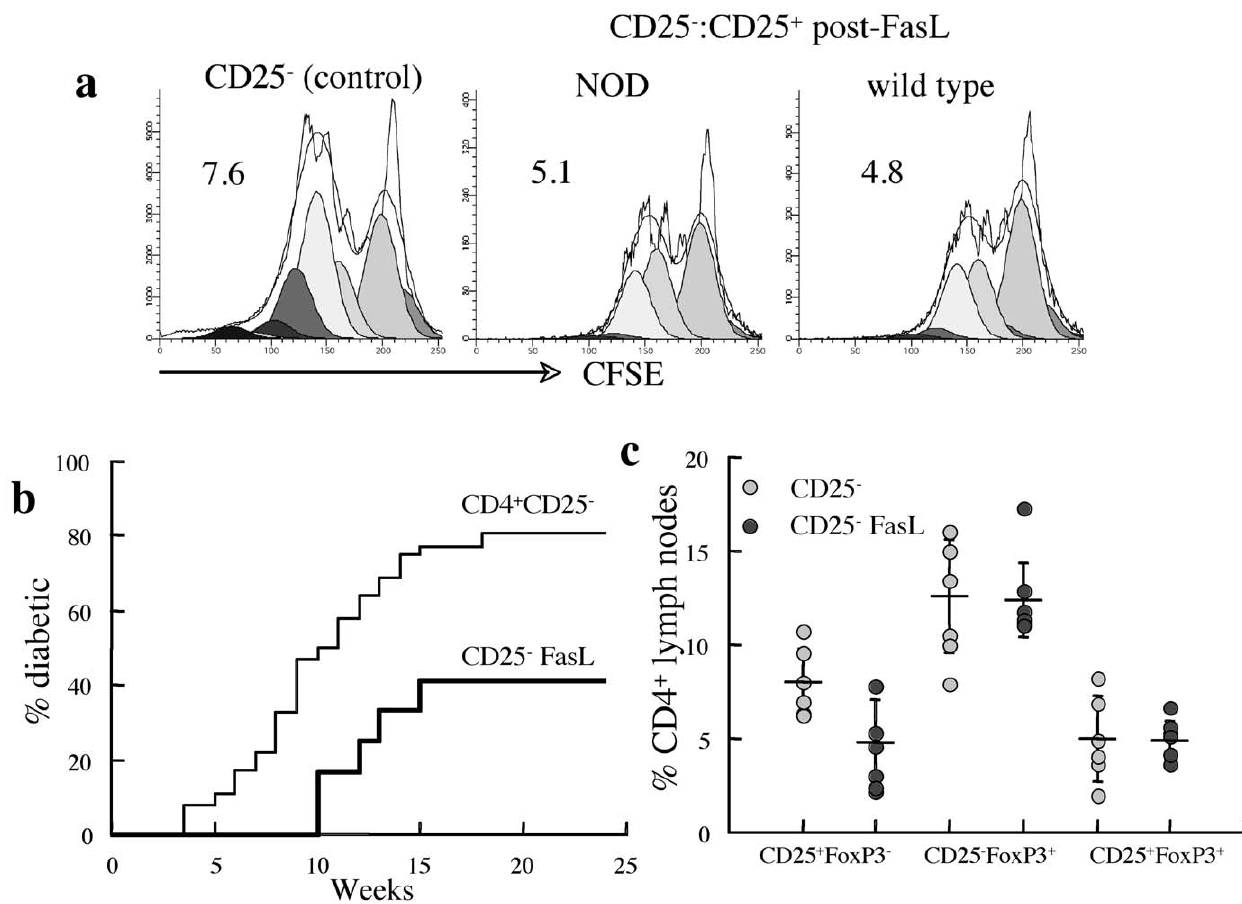
Figure 3. Impact of FasL on effector and regulatory T cell activity. A. Inhibition of proliferation of CFSE-labeled CD25 2 T cell responders activated with CD3/CD28 (control) by CD25 + T cells isolated from NOD and wild type mice after incubation with FasL at a Teff:Treg ratio of 3:1. Data are representative of four experiments in which CD25 + suppressor cells were co-incubated with CFSE-labeled CD25 2 responders from the same strain. B. NOD.SCID mice were adoptively transferred with 2.5 6 10 7 naı¨ve (n=36) and FasL-coated CD25 2 T cells (n=12) from prediabetic NOD females. Blood glucose was monitored to determine onset of diabetes at levels . 200 mg/dl. C. Fractional expression of CD25 and FoxP3 in CD4 + T cells from mesenteric/pancreatic lymph nodes of NOD.SCID mice reconstituted with naı¨ve (n=6) and FasL-coated (n=5) CD25 2 T cells from prediabetic NOD females.